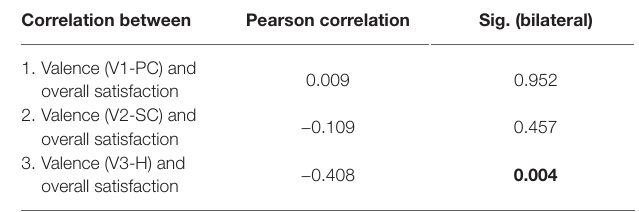
TABLE 2 | Correlations of valence and arousal during each video (SAM). Correlation between Pearson correlation Sig. (bilateral)